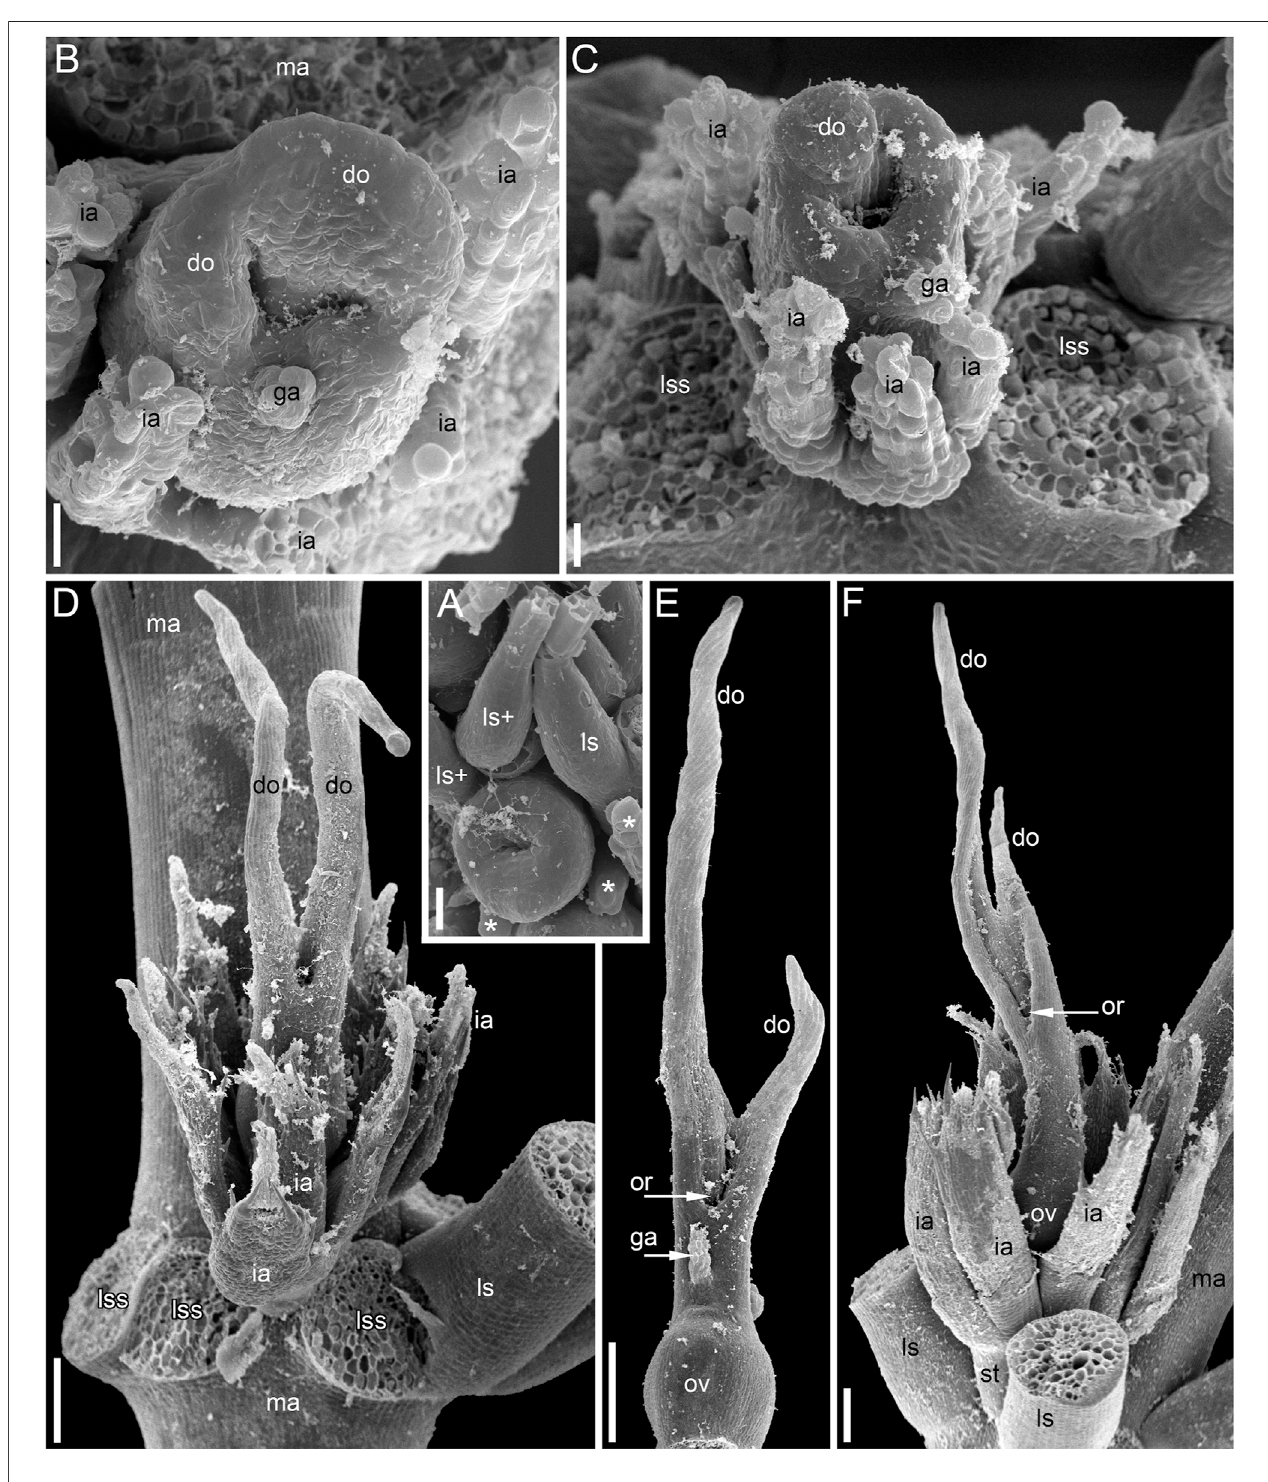
FIGURE 3 | Pistillate fl owers of Ceratophyllum demersum (SEM). (A) Very young fl ower with involucral appendages of the reproductive unit and any gynoecium appendages still inconspicuous. Adaxial side up. Small organs near the fl ower (asterisks) are leafy segments of a vegetative branch situated below the fl ower. (B,C) Young fl owers, adaxial side up. The glandular gynoecial appendage is already well-developed, but distal outgrowth(s) are still very short. (B) Gynoecium developing a bilobed distal outgrowth or two distal outgrowths, a wider one adaxial and a narrower one left transversal; the gland is abaxial. (C) The gland and a young distal outgrowthareattheoppositeradii,whichareobliquerelativetothemedianplaneofthe fl ower.Notethatthe fl owerisextra-axillary,locatedbetweentwovegetativeleafy